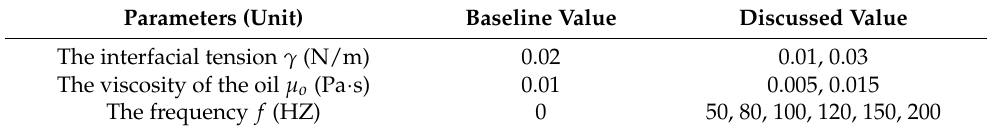
Table 1. The frequency of various conditions.